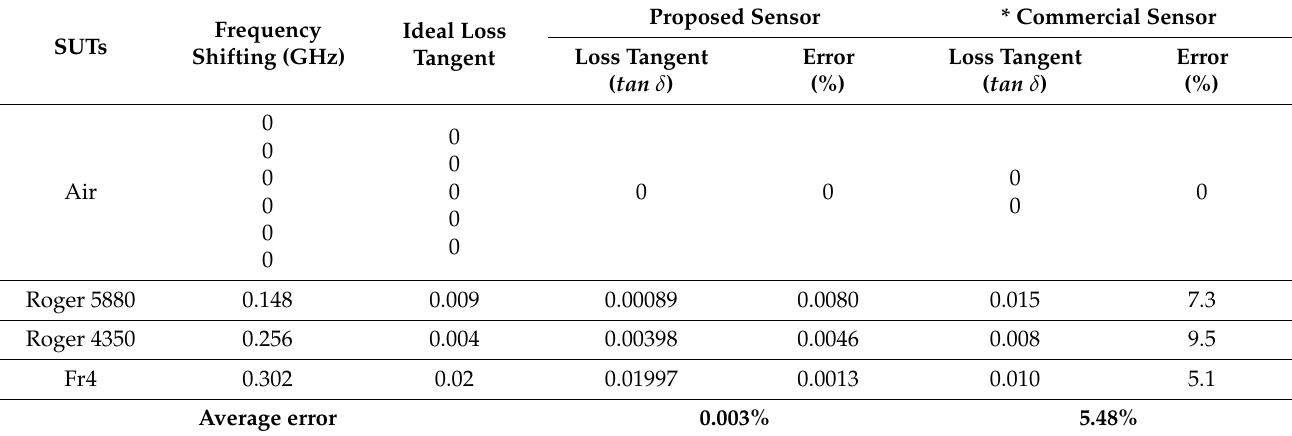
Table 7. Comparison percentage error of loss tangent between the proposed and commercial sensor of SUTs.